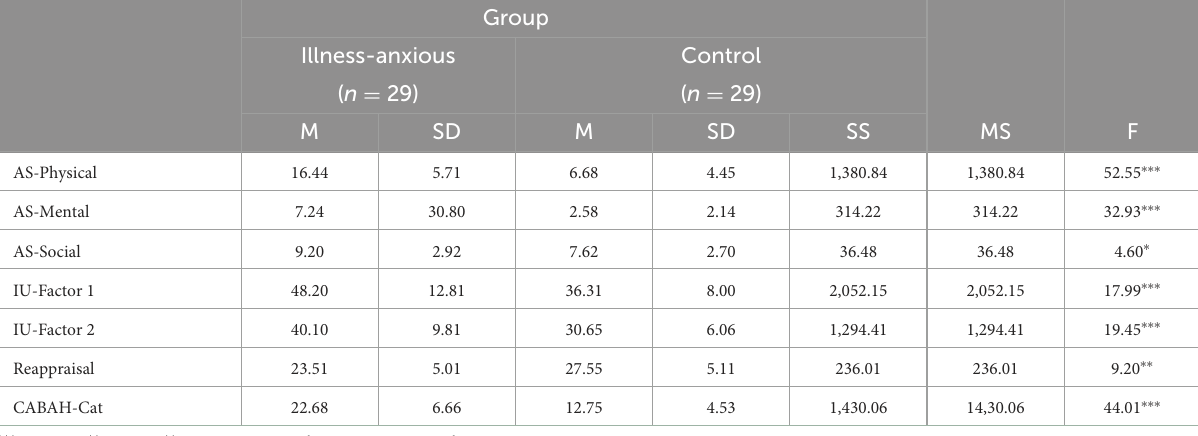
TABLE 2 Results of descriptive statistics and MANOVA for between-group differences in task-related variables: AMB-Safe, AMB-Unsafe, HR-Unsafe, and NHR-Safe.